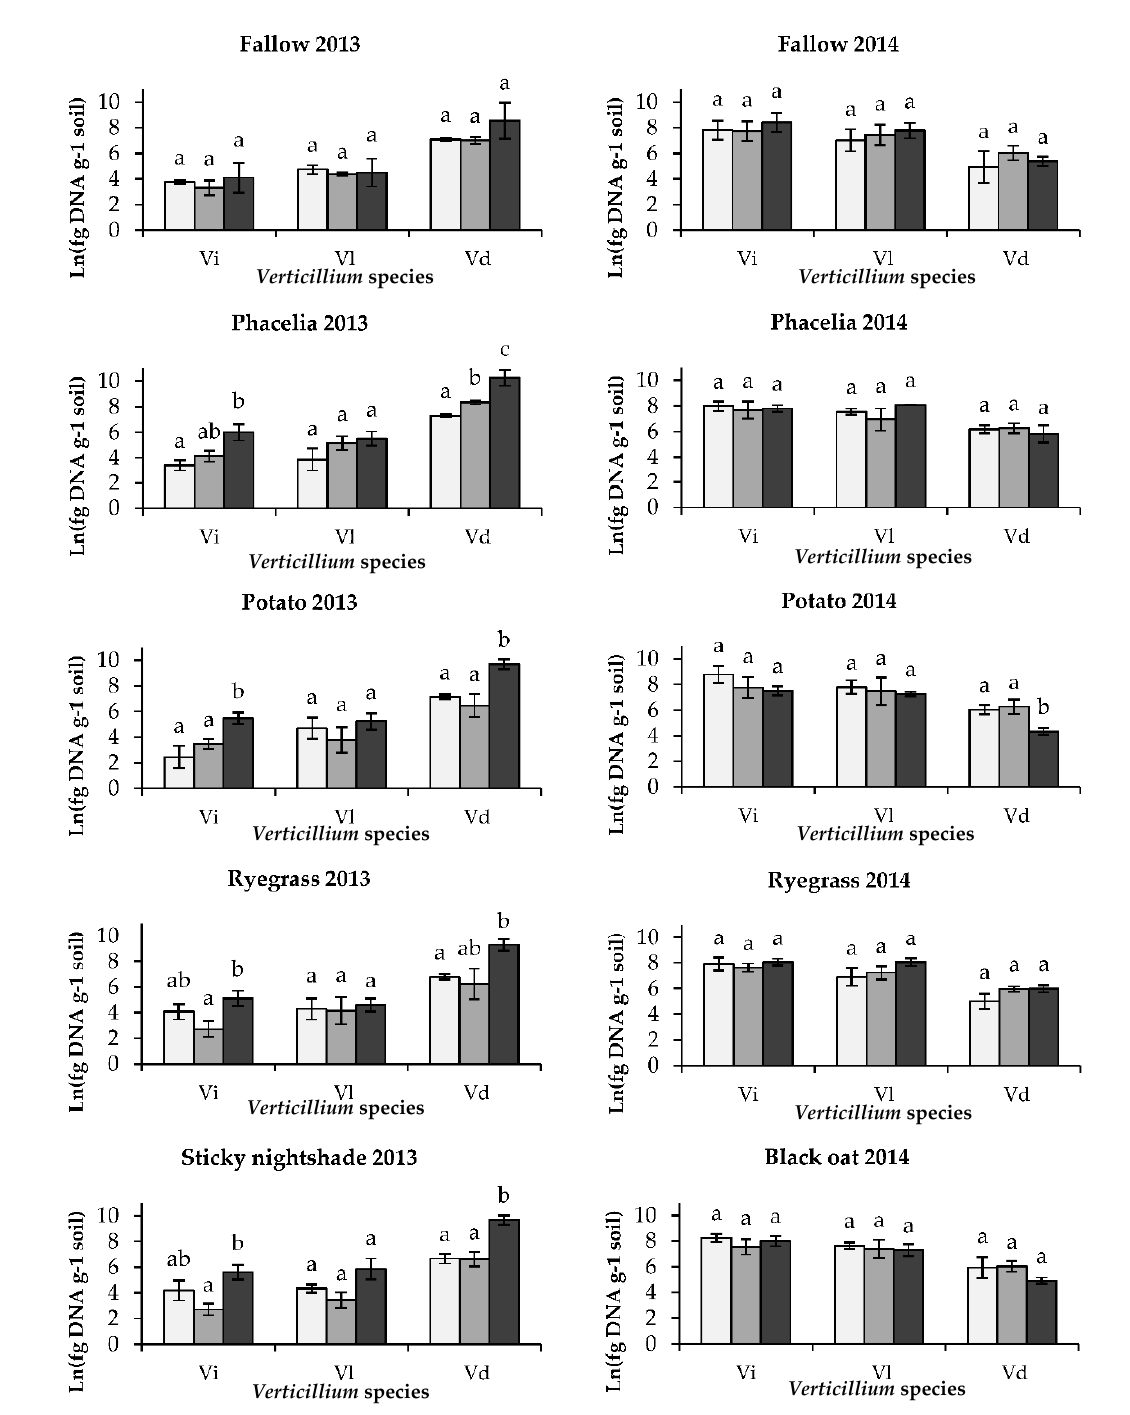
Figure A2. Inoculum densities of V. isaacii (Vi), V. longisporum (Vl) and V. dahliae (Vd) at three time points ( : sowing/planting of crop 1, : incorporation of crop 1 and : harvest of cauliflower) in a grower’s fields located in Puurs during the growing seasons of 2013 and 2014 in five cover crop systems. Values are the mean of 4 replicates and the vertical bars represent the standard error of the mean. Data were ln transformed before statistics. For each Verticillium species, bars with different letters indicate statistical differences according to Tukey tests ( p < 0.05).